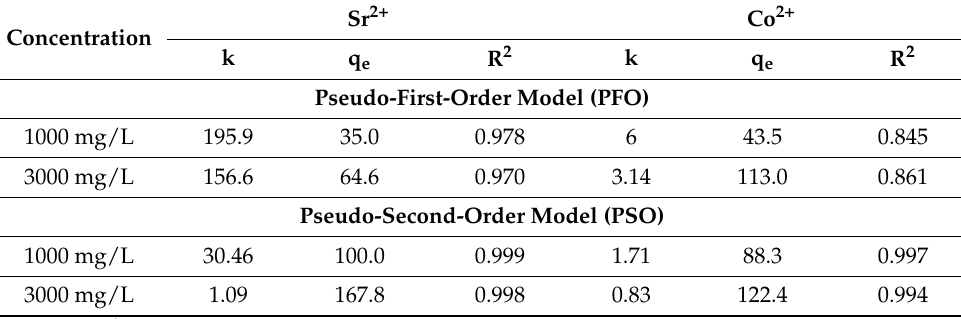
Figure 5. ( a , b ) Kinetic adsorption; ( c , d ) PFO model and ( e , f ) PSO plots of Sr 2+ or Co 2+. Table 3. Kinetic adsorption parameters of BK3 by PFO and PSO